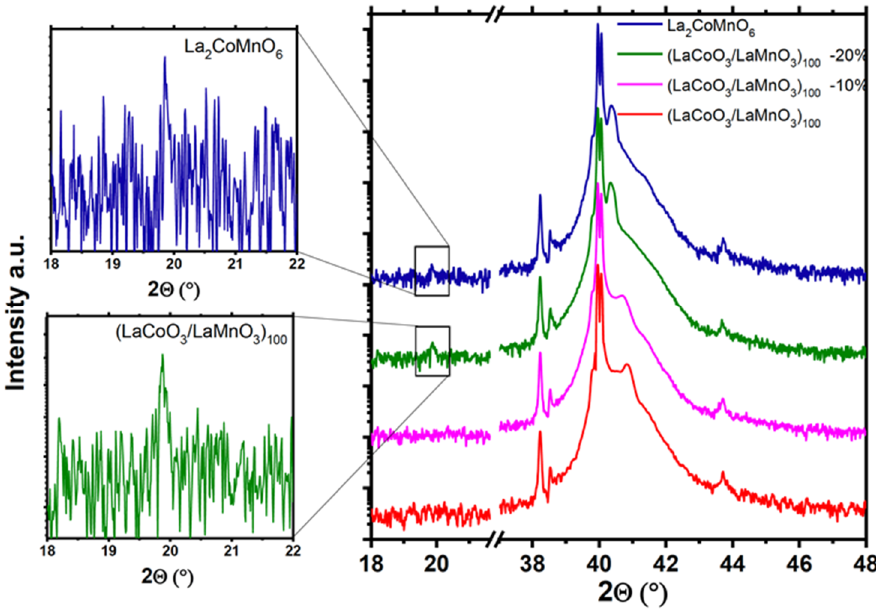
Figure 8. XRD measurements of LCMO SoA (blue), LCO/LMO SL: L1(red), L2 (magenta), and L3 (green).